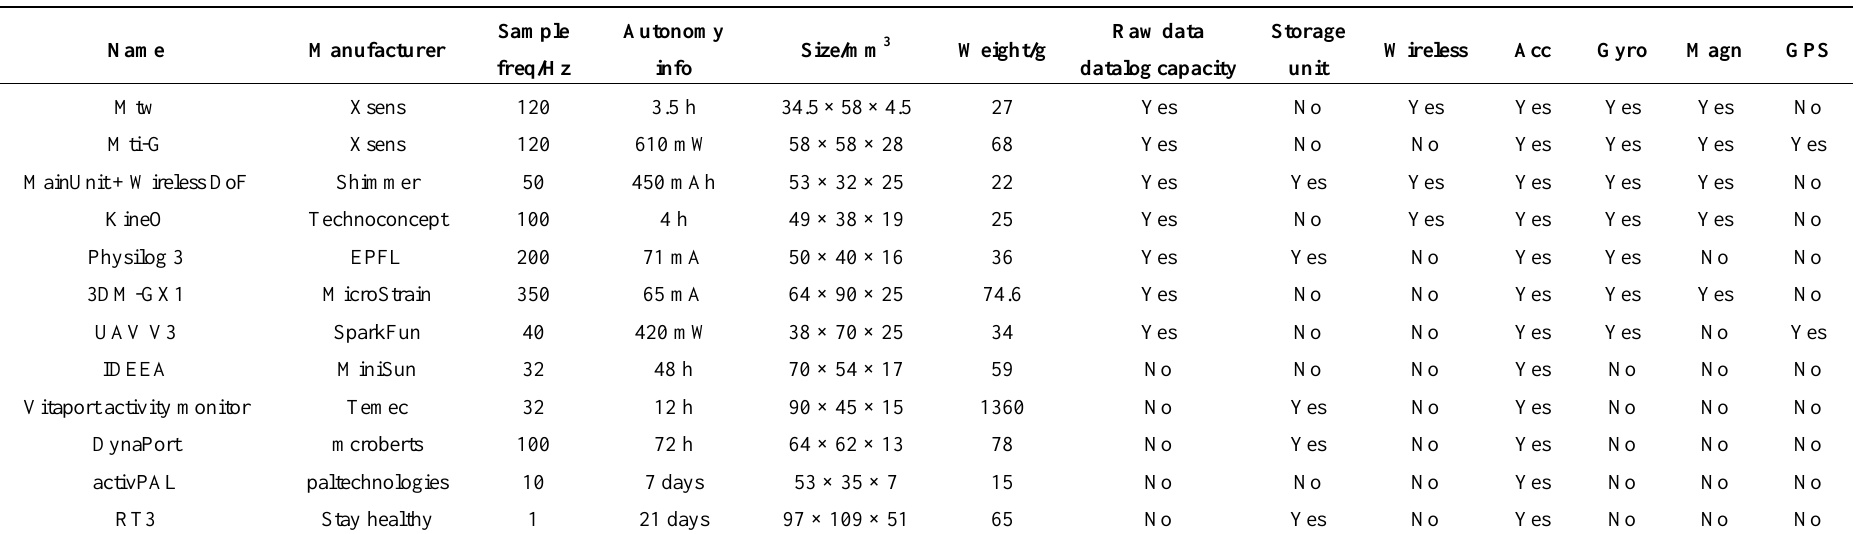
Table 1. Commercial Inertial Measurement Units